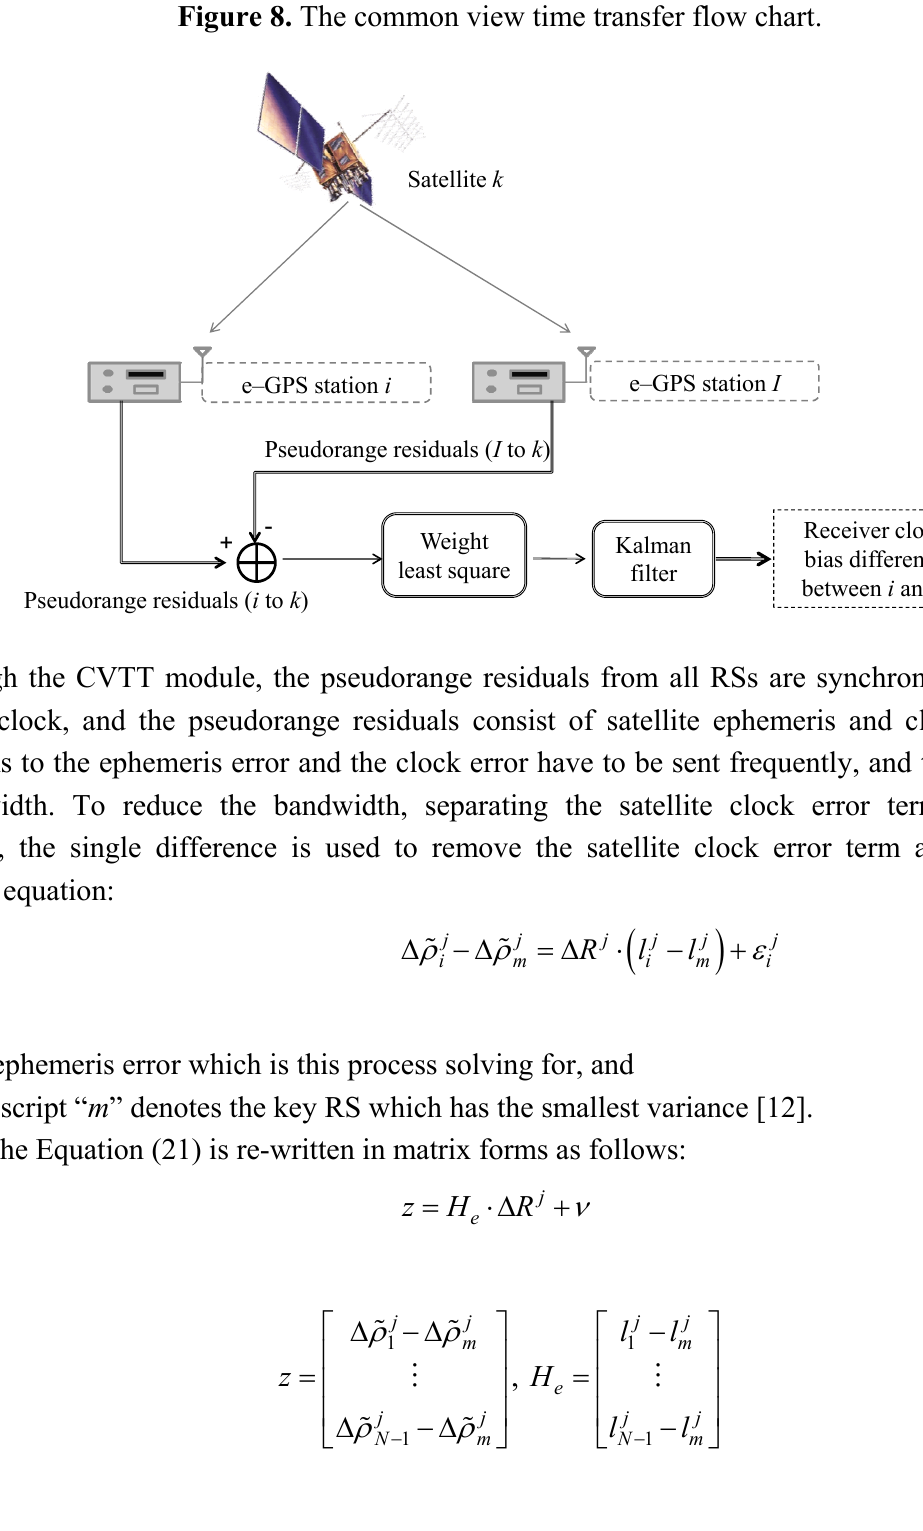
Figure 8. The common view time transfer flow